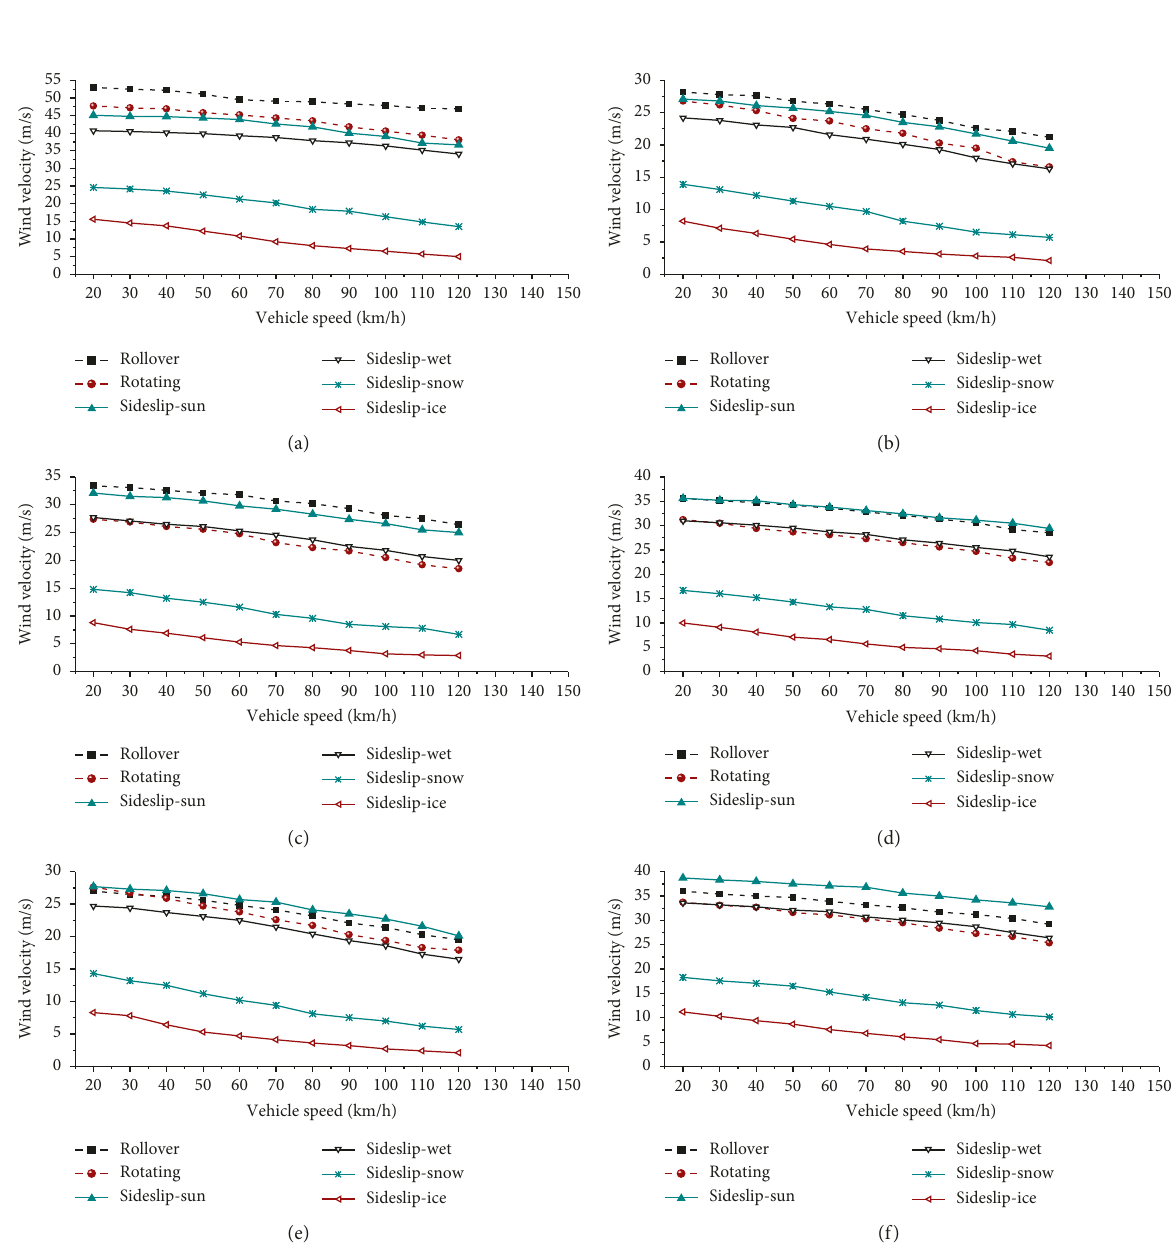
Figure 9: Safe driving critical value of the vehicle-bridge system: (a) sedan, (b) minibus, (c) microbus, (d) motor bus, (e) van, and (f) container